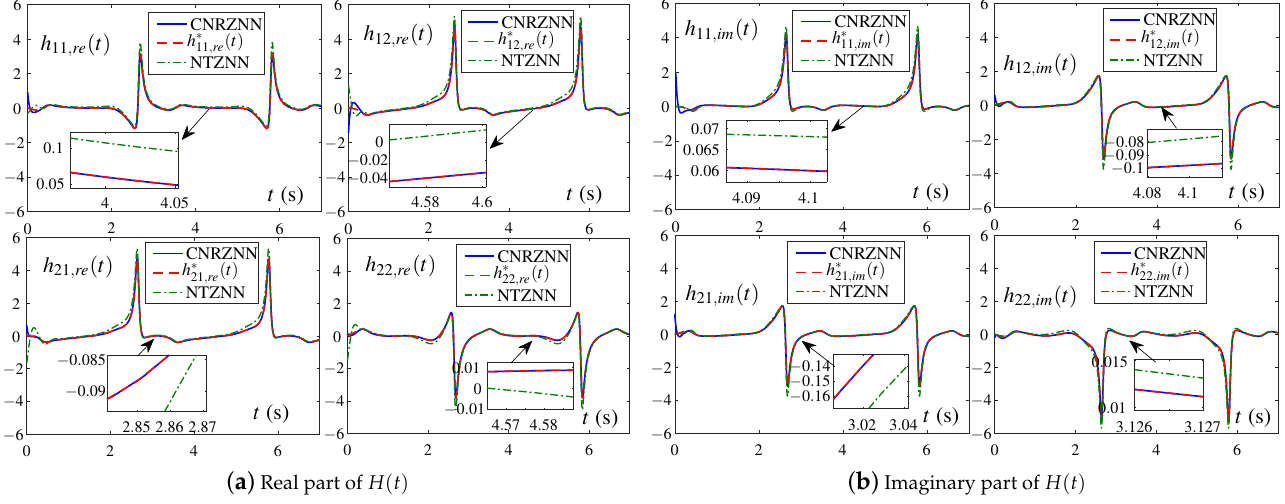
Figure 6. CNRZNN model and NTZNN model for solving CTDLE (15) under complex linear noises [( 50 + 50 i ) t ] 2 × 2 . ( a ) Real part of the state matrix H ( t ) . ( b ) Imaginary part of the state matrix H ( t ) . Additionally, the CNRZNN model is further compared with the NTZNN model under the complex quadratic noise. In this work, the CNRZNN model and NTZNN model are employed to solve CTDLE (15) under complex quadratic noises W 8 ( t ) = [( 5 + 5 i ) t 2 ] 2 × 2 , L ( t ) and the is used to estimate the robustness of the model. In Figure 7c, the (cid:107) (cid:107) F of CNRZNN model (7) with design parameter ζ = 10 is of order 10 − 1 . However, under the L ( t ) same conditions, the of NTZNN model (9) is divergent. Then, we adjust the (cid:107) (cid:107) F